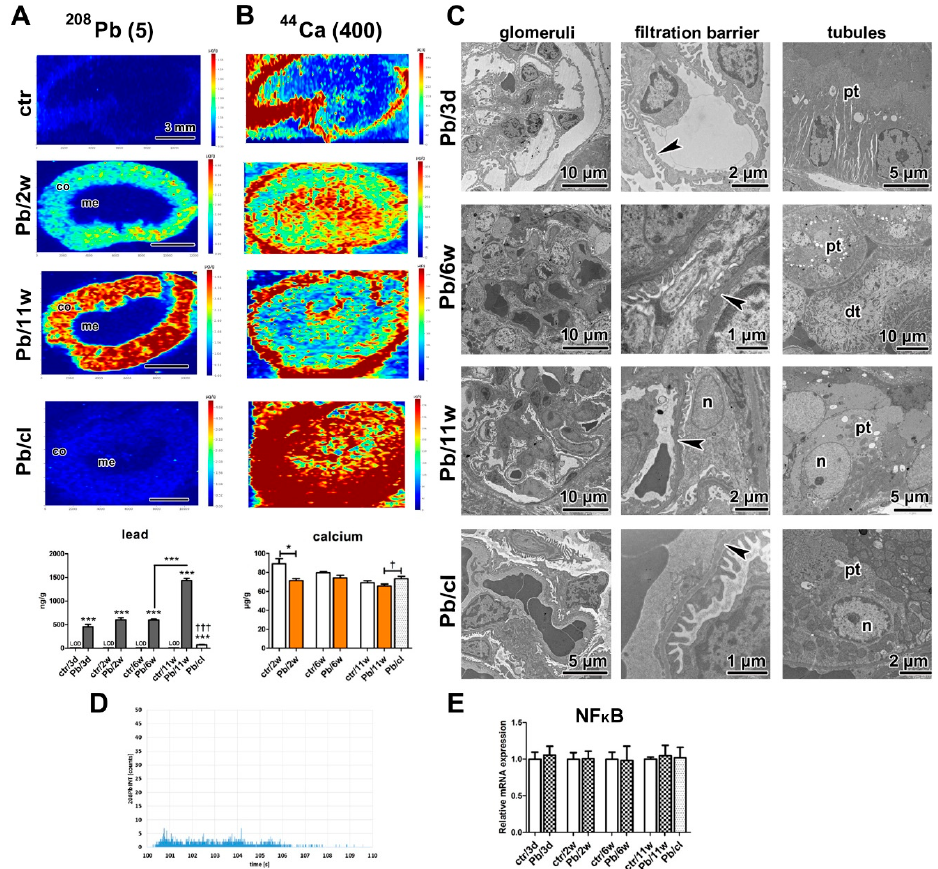
Figure 5. The effect of Pb(NO 3 ) 2 NP inhalation and its clearance on the kidney. ( A ) Distribution of Pb in kidney samples using laser ablation inductively coupled plasma mass spectrometry (LA-ICP-MS) after Pb(NO 3 ) 2 NP inhalation. The control kidney was without Pb positivity, Pb was detected in kidney cortex (co) after Pb(NO 3 ) 2 NP inhalation but not in the medulla (me). After a 5-week clearance period, Pb was still present in kidney cortex. The graph of Pb level in the kidney at designated time points. The graphs values denote average ± SD for 5 mice/group, *** p < 0.001 compared with the corresponding control group (or between adjacent time points), and ††† p < 0.001 compared with the corresponding Pb(NO 3 ) 2 NP group by unpaired t -test. Limit of detection (LOD) for Pb in the kidney was 9 ng/g. Number in parentheses shows maximal value (µg/g) of Pb on a scale. ( B ) Distribution of Ca in kidney samples using LA-ICP-MS after Pb(NO 3 ) 2 NP inhalation. The map of Ca exhibited higher distribution in kidney in Pb/cl group compared with the control and Pb(NO 3 ) 2 NP group. The graph of Ca level in the kidney at designated time points. Kidney Ca was significantly decreased after 2-week Pb(NO 3 ) 2 NP inhalation (* p < 0.05) compared with the corresponding control group (ctr) and significantly increased in Pb/cl group († p < 0.05) compared with the corresponding Pb(NO 3 ) 2 NP group. Number in parentheses shows maximal value (µg/g) of Ca on a scale. Scale bar in panels ( A , B ) = 3 mm. ( C ) Analysis of kidney ultrastructure in the transmission electron microscope (TEM). Proximal (pt) and distal tubules (dt) were without pathological changes up to 6-week Pb(NO 3 ) 2 NP inhalation. After 11-week Pb(NO 3 ) 2 NP inhalation, the proximal tubules of kidney exhibited changes both in nuclear (n) and cytoplasmic (c) architecture. A 5-week clearance period conducted to rescue of proximal tubule cells. The glomerular filtration membrane (GFM, arrowheads) was altered after 6-week Pb(NO 3 ) 2 NP inhalation. The nuclear alterations were observed also in nuclei (n) of podocyte (po) after 11-week Pb(NO 3 ) 2 NP inhalation. Scale bars are displayed individually for each picture. ( D ) Time-resolved signal originated from kidney tissue exposed to Pb(NO 3 ) 2 NPs. ( E ) Gene expression of NF- κ B at selected time points after Pb(NO 3 ) 2 NP